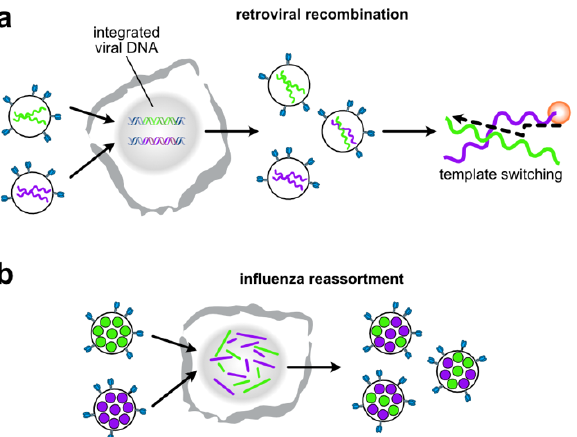
Figure 6. Viral RNA packaging influences viral evolution. ( a ) HIV-1 virions contain two copies of the genome. After co-infection, up to 50% of progeny co-package different genomes. Template switching during reverse transcription produce cDNA that is a chimera of the two genomes; ( b ) Influenza A virions contain eight different vRNA segments. After co-infection, reassortant progeny virions are produced containing a mixture of segments from each parental virus.